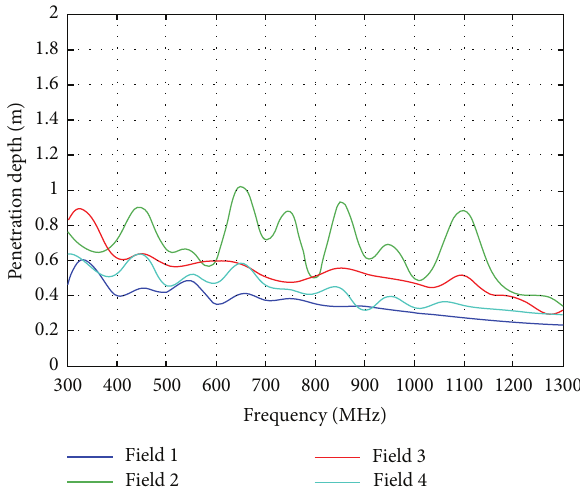
Figure 1: Penetration depth for soils described in